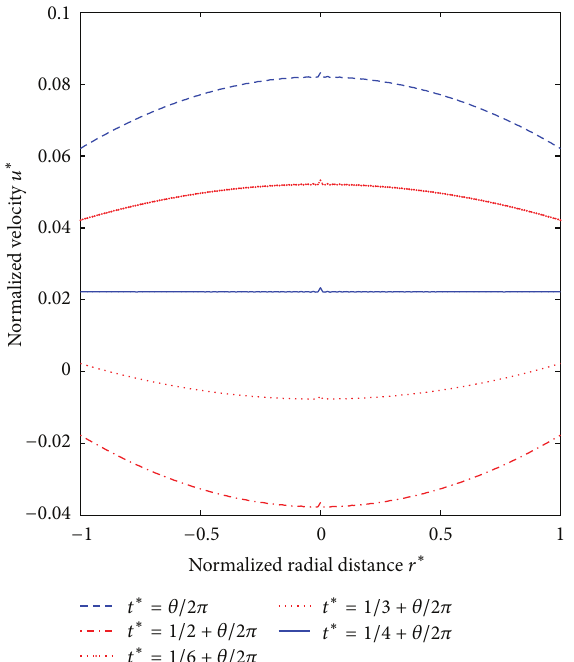
Figure 4: Typical velocity profile for the mixed pressure and electric driven flow at various instants of time 𝑡 ∗ , obtained with slip length 𝐸 󸀠 /𝑎 = 10 −6 , and 𝐾 = 1500 . 𝑙 ∗ = 1 , 𝜓 𝑠 1 𝑧